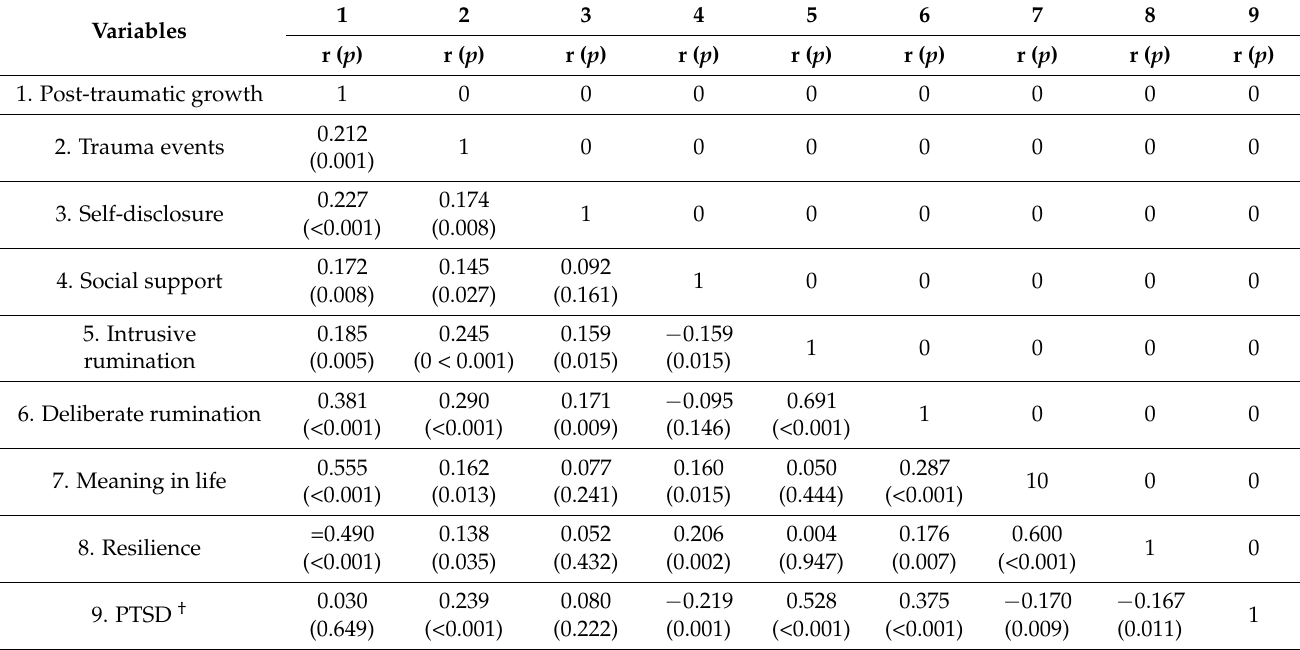
Table 3. Correlation between the research variables (N =